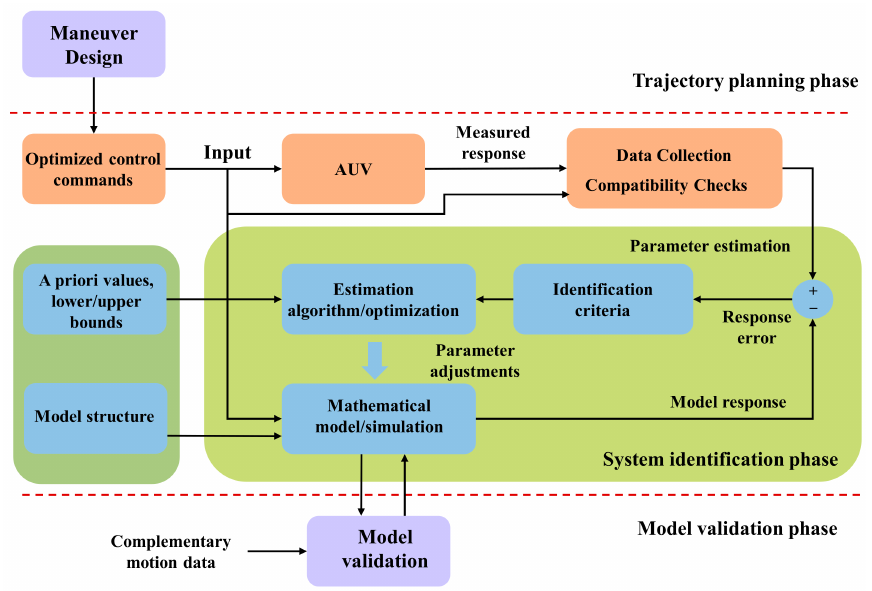
Figure 3. The schematic diagram of AUV system identification